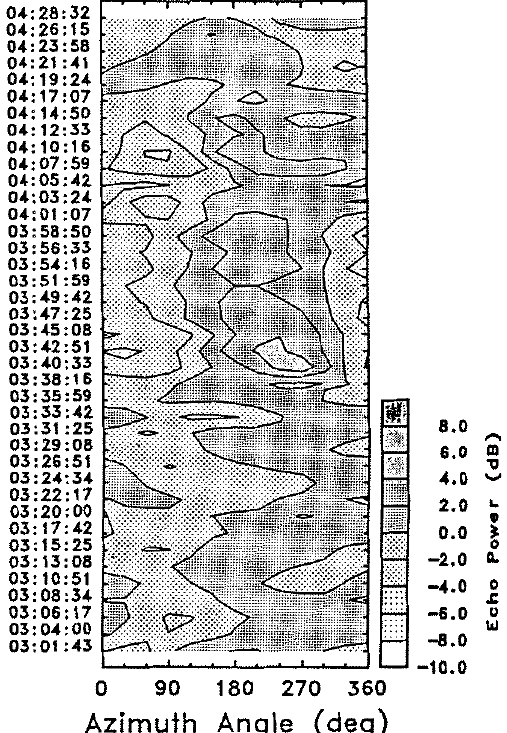
Fig. 3. Contour plot of azimuth angle variations of the echo power as a function of time (every 137 s) at 6 degrees off tbe zenith and a 6.85km altitude with the MU radar. For this case, single humped time variations are clearly observed (after Tsuda et al., 1997b).